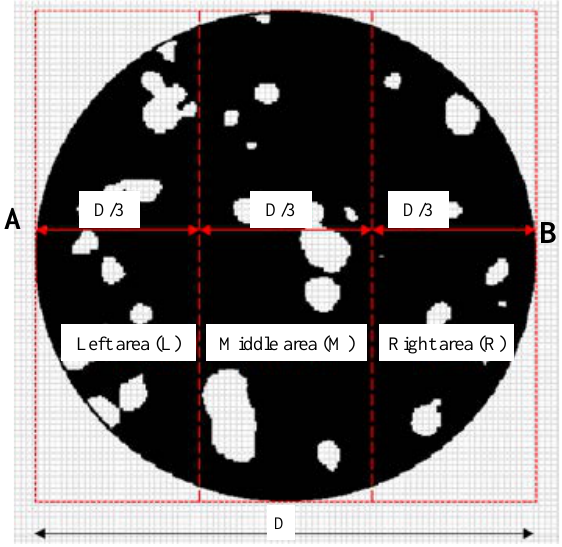
Figure 7. Cross-sectional zoning diagram. Six cross-sectional CT images (S120, S130, S140, S150, S160, and S170) were uniformly selected along the height direction of the concrete specimen (Figure 2), and for the holes and cracks in the L, M and R areas of the six cross-sectional CT images, their respective average values of roundness were calculated at the five scanning stages. The average value of roundness is shown in Figure